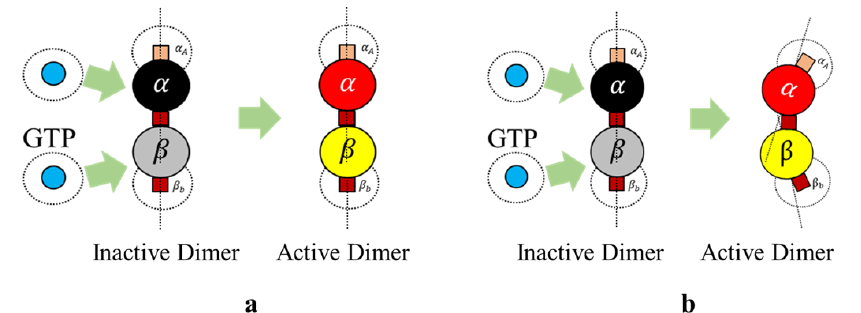
Figure 5. ( a ) Activation of dimer by GTP in protofilaments according to Rule 3a; ( b ) Activation and displacement of bonds in a dimer according to Rule 3b.